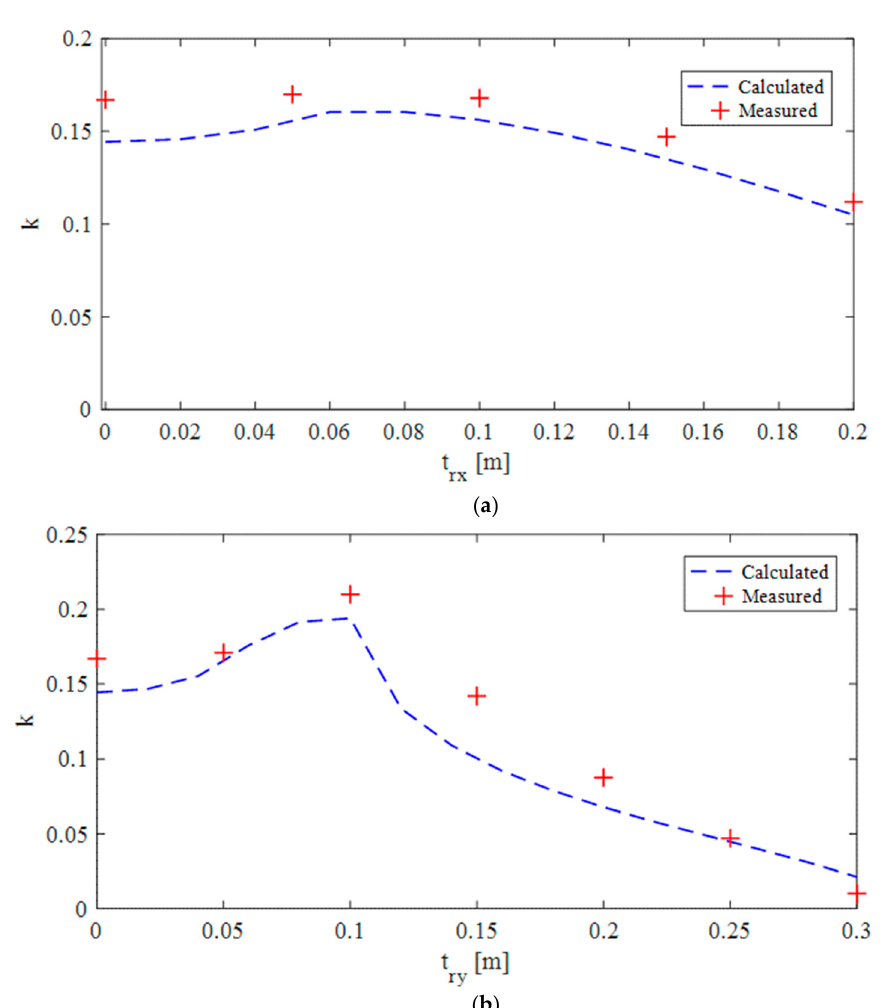
Figure 13. Calculated and measured coupling factor k vs misalignment along x -axis ( a ) and y- axis ( b ).